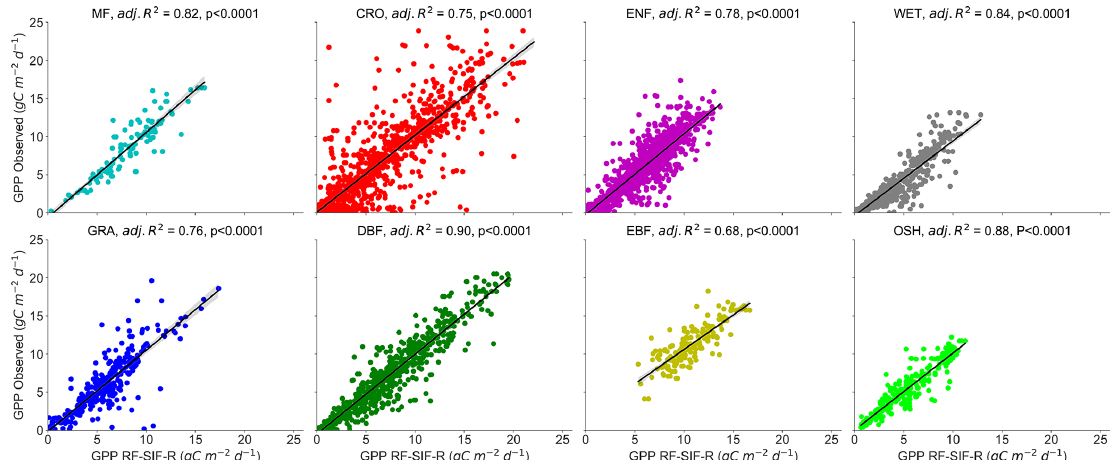
Figure 7. Scatterplots of observed GPP against RF-SIF- R -predicted GPP in eight PFTs at daily timescales. The adj. R 2 represents the adjusted coefficient of determination of the relationship between observed GPP and predicted GPP. p denotes the probability value of the